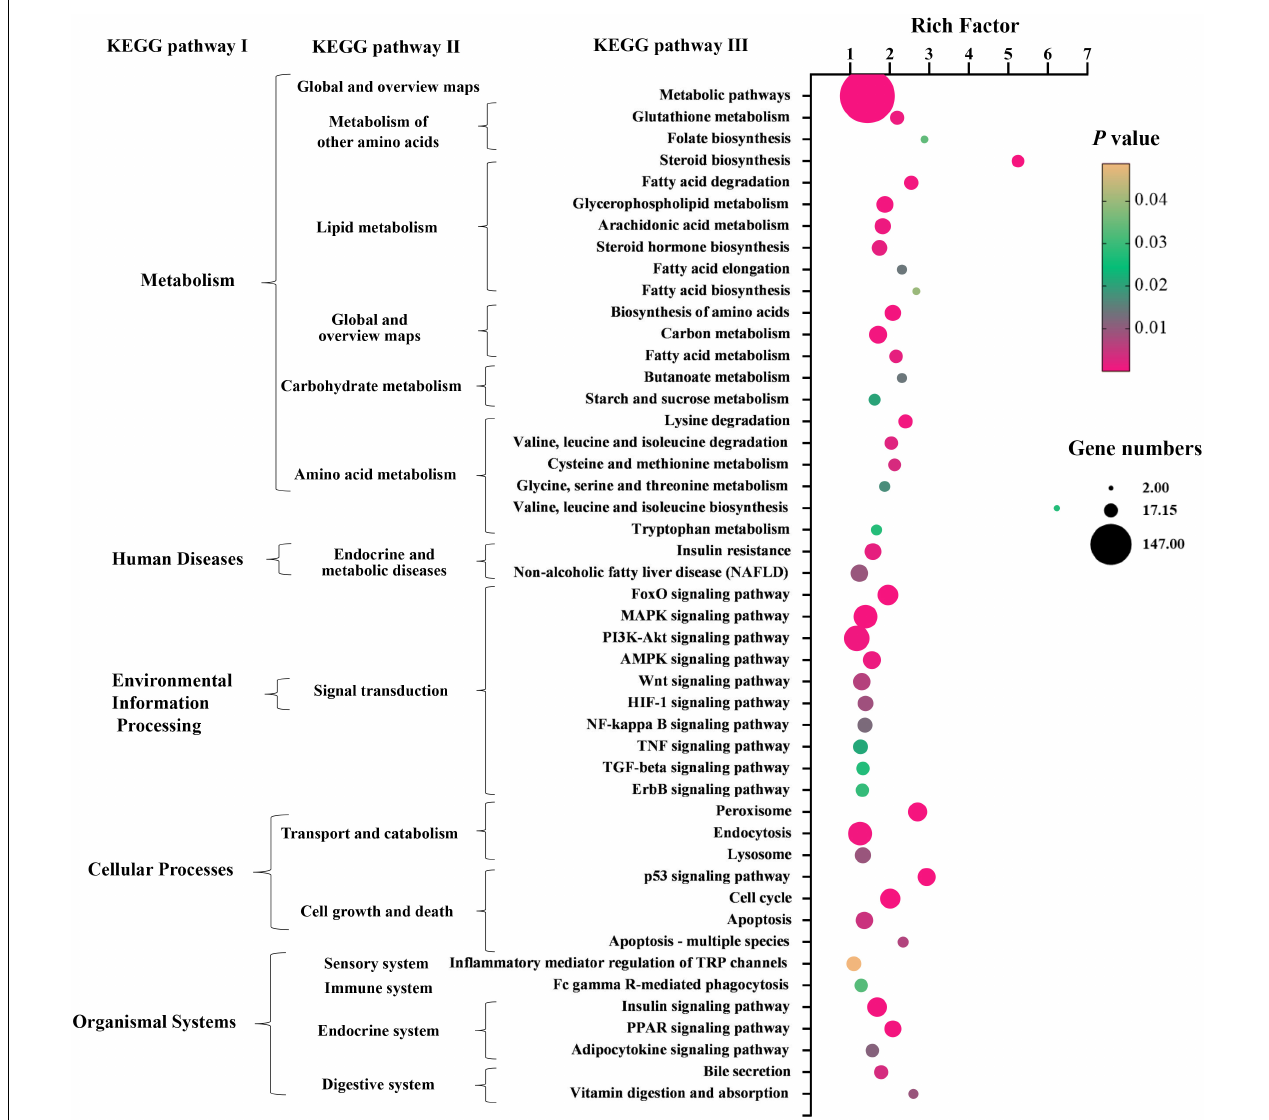
FIGURE 4 | PPC supplementation modulates KEGG pathways in HFD mice. The bubble chart shows the dysregulated terms in three KEGG levels between HFD + PPC and HFD mice ( P < 0.05). The larger the point, the more genes fall into this pathway and the yellower point means the higher significance of